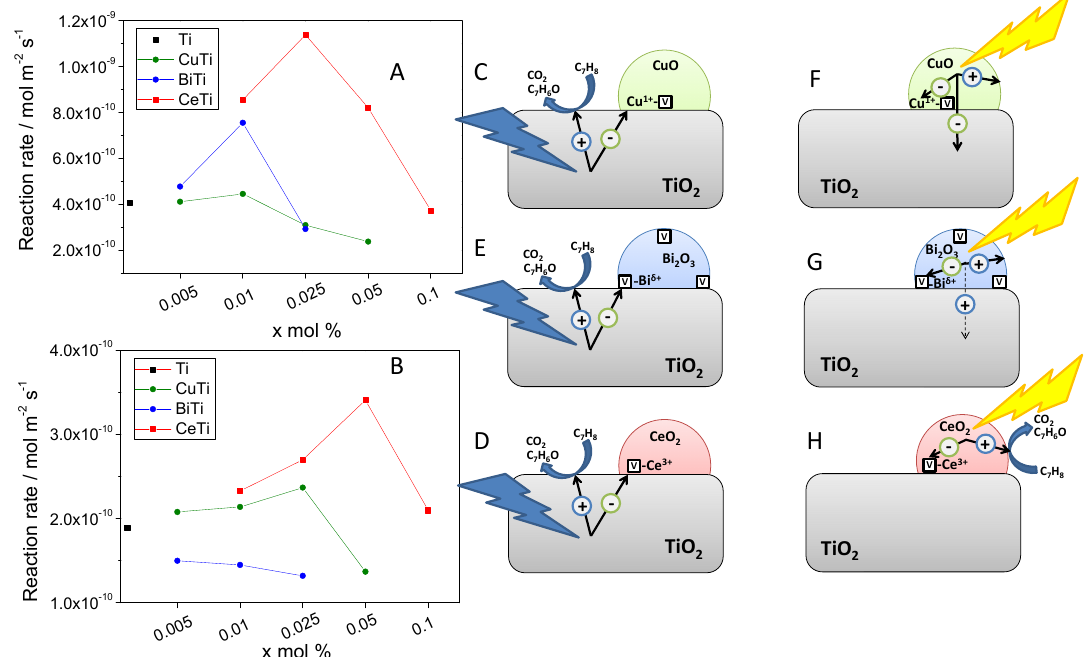
Figure 4. Reaction rate for of the samples (CuO-, Bi 2 O 3 - and CeO 2 -TiO 2 ) and TiO 2 reference prepared by microemulsion method under UV ( A ) and Sunlight-type ( B ) illumination conditions. Schematic representation of the interface role in the composite samples under UV ( C – E ) and Visible ( F – H ) irradiation. Reprinted with permission from [73]: Muñoz-Batista, M.J. et al.; ACS Appl. Mater. Interfaces. 2016, 8, 13934–13945. Copyright © 2020 American Chemical Society.